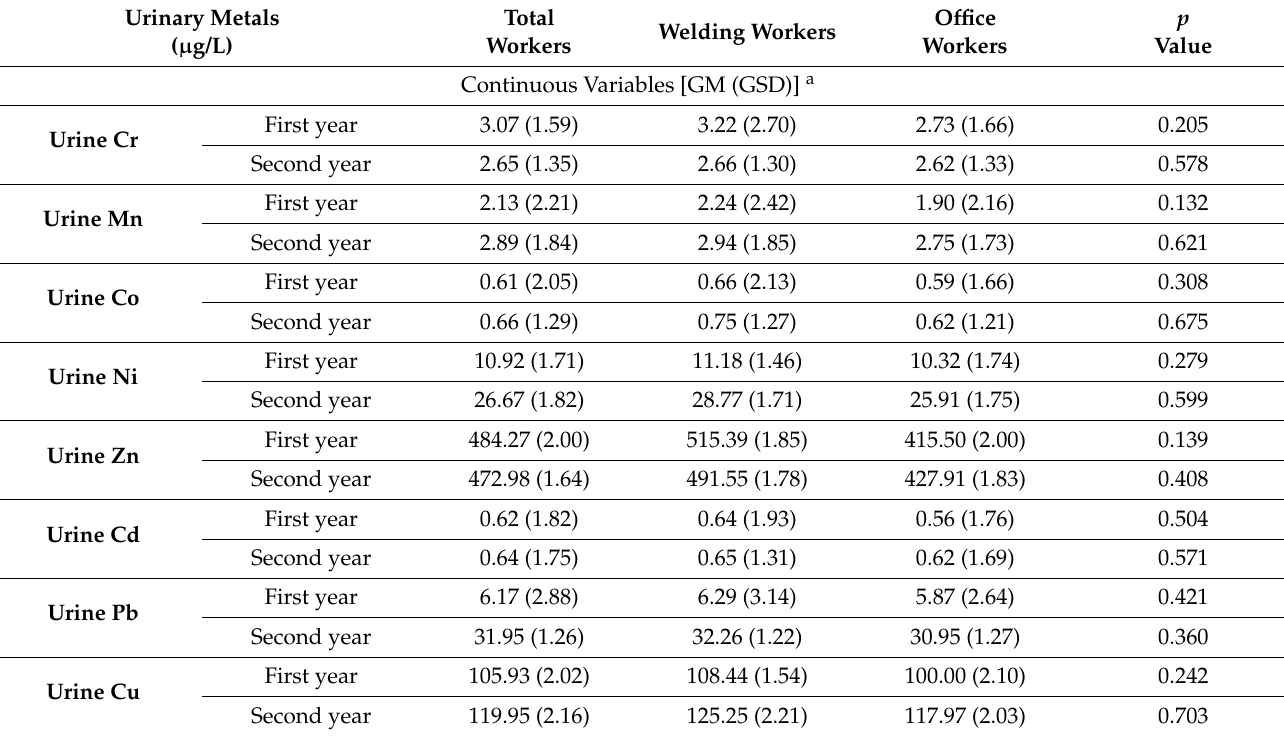
Table 2. The concentration of urinary metals in welding and office workers in 2-year